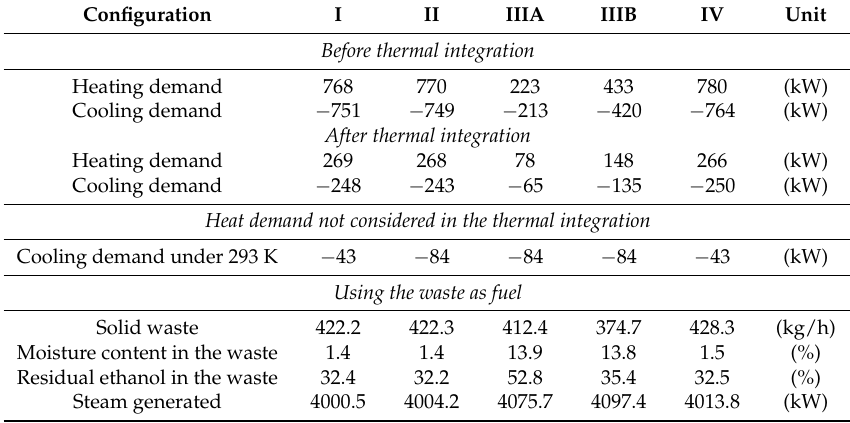
Table 7. Heating and cooling demand and steam generated using the annatto seeds residue for the evaluated annatto seeds-sugarcane biorefinery